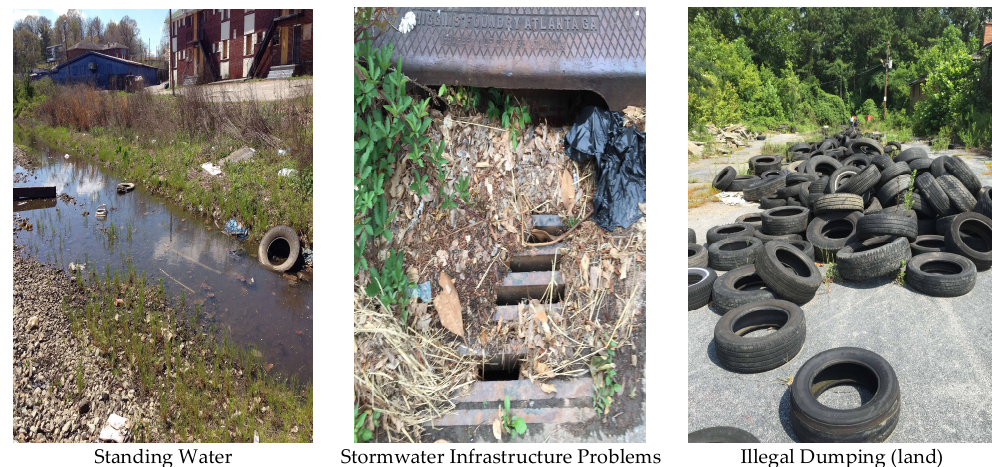
Figure 5. Areas of highest density (depicted by the colors yellow and red) of illegal dumping on land and locations of stormwater infrastructure problems in the Proctor Creek Watershed (does not denote statistical significance).